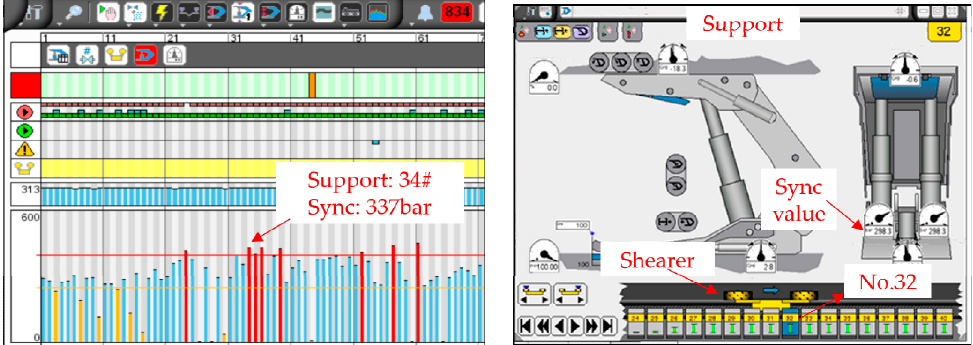
Figure 6. Pressure monitoring equipment in the 22201 working face.